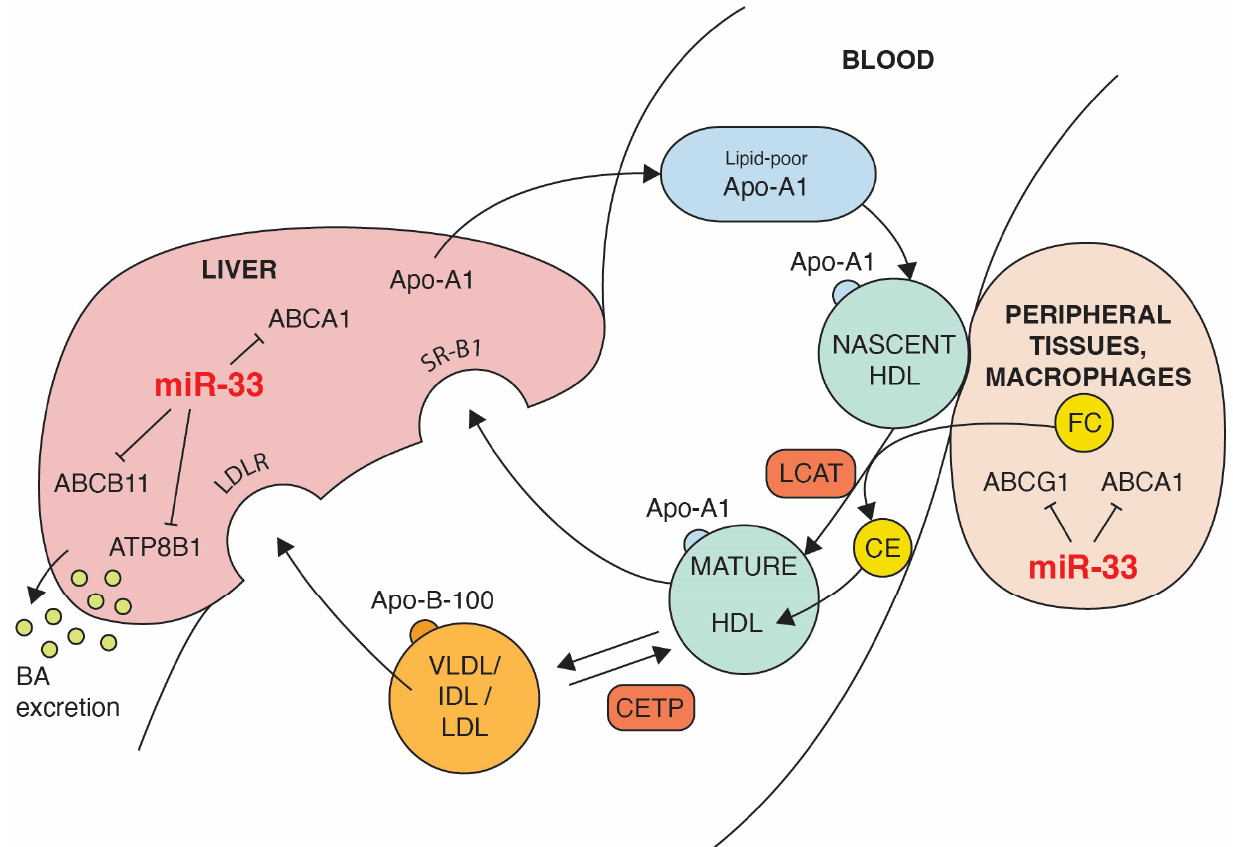
Figure 2. The impact of miR-33 on some steps of reverse cholesterol transport (RCT). Black lines ending with a short perpendicular line indicate target genes that are repressed by miR-33. ABCA1- mediated lipidation of lipid-poor apolipoprotein A-I (Apo-A1) forms nascent HDL. Cholesterol efflux from extrahepatic cells, including macrophages, is mediated by ABCA1 and ABCG1 activity. Through the action of the lecithin:cholesterol acyl transferase (LCAT), free cholesterol (FC) is esterified and cholesterol esters (CE) are absorbed inside of HDL. The progressive action of LCAT on nascent HDL generates a spectrum of mature HDL particles. Part of CE can be transferred by cholesterol ester transfer protein (CETP) from HDL to apolipoprotein B-100 containing lipoproteins (VLDL, IDL, LDL) in exchange for triglycerides (TG), promoting cholesterol clearance by the LDL receptor. Hepatic SR-BI mediates removal of FC and CE from HDL. Excess cholesterol is converted to bile acids excreted from the liver into the bile. Both the ABC11 and ATP8B1 transporters promote hepatic excretion of the